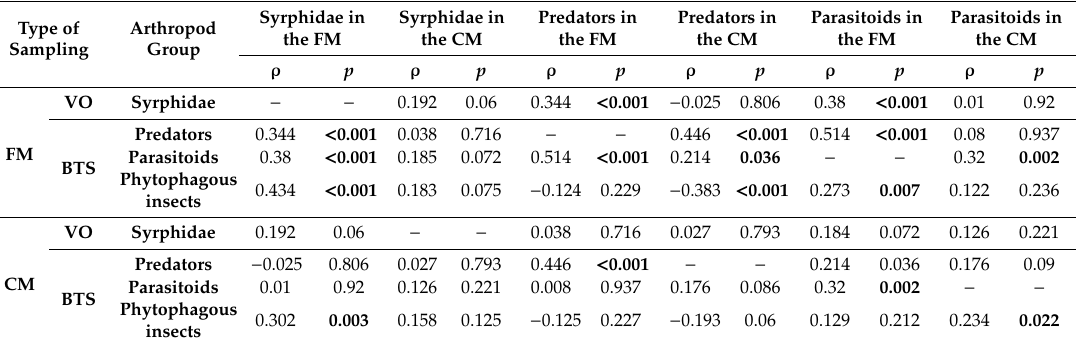
Table 2. Spearman correlation coe ffi cients between: adult hoverflies (Syrphidae) from the visual observations (VO), predators, parasitoids and phytophagous insects from the beating tray samplings (BTS)) found in the flower margin (FM) and in the control margin (CM).